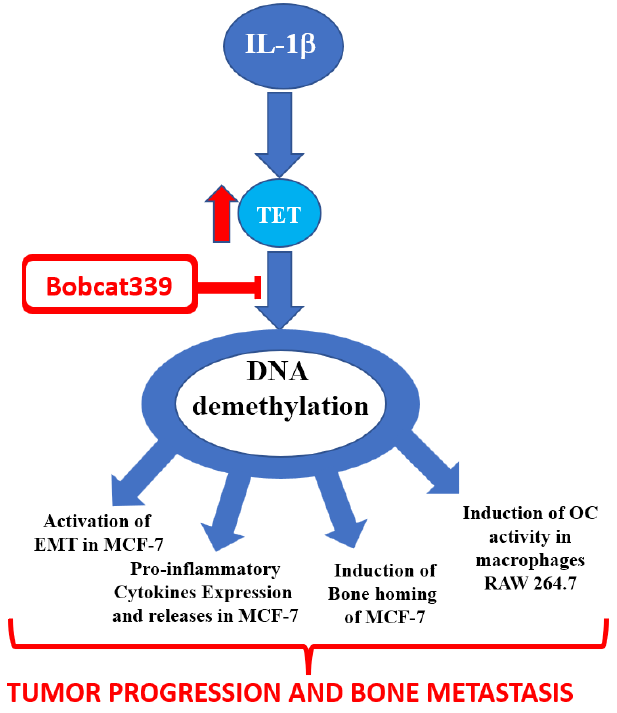
Figure 8. Schematic drawing that indicates Bobcat339 interferes in tumor progression and bone metastasis through TET inhibition.